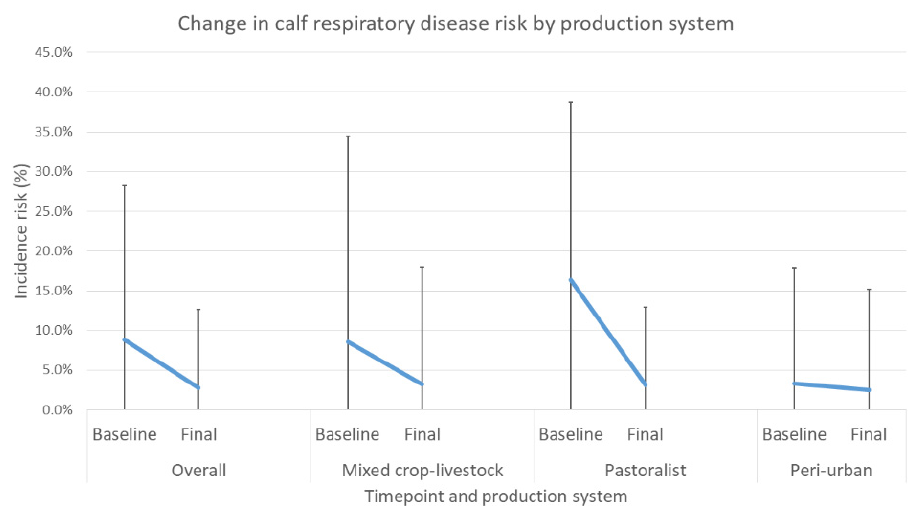
Figure 8. Change in average respiratory disease risk in calves between baseline and final overall evaluation and for each production system with standard deviation bars.